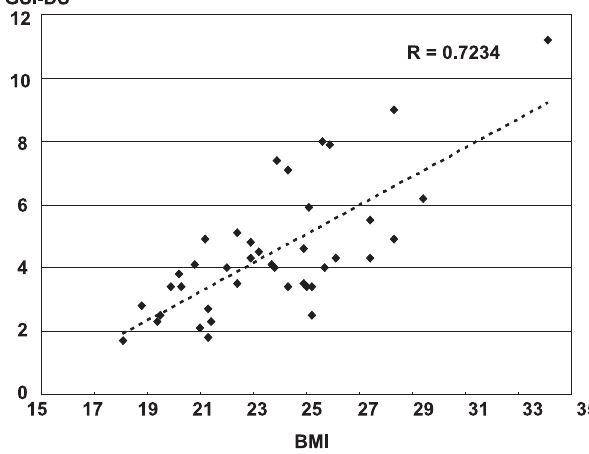
Figure 2 - Correlation between the general stability index on the dominant side (GSI-DS) and the body mass index